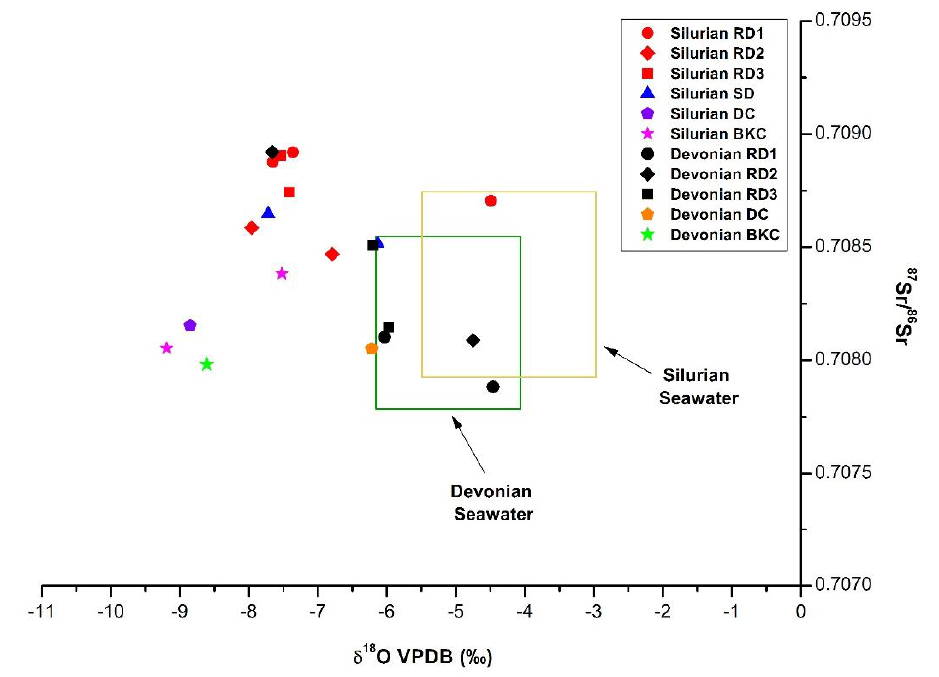
Figure 12. Cross plot of δ 18 O vs 87 Sr/ 86 Sr ratios of different dolomitic and calcitic components from the two age groups. In both age groups, Sr isotopic ratios show seawater composition of their respective age as the primary source of diagenetic fluids with minor rock-water interactions as indicated by some exceptions of more radiogenic signatures in the Silurian formations. The green box represents Devonian seawater [51] and the yellow box represents Silurian seawater [51,52]. 87 Sr/ 86 Sr isotopic ratios for dolomite and calcite by age are presented in Table 3.